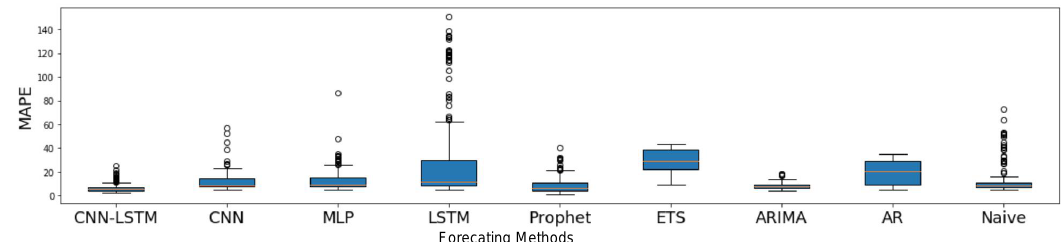
Figure 12. The distribution of MAPE across cells in a 24-h-ahead forecasting scenario.